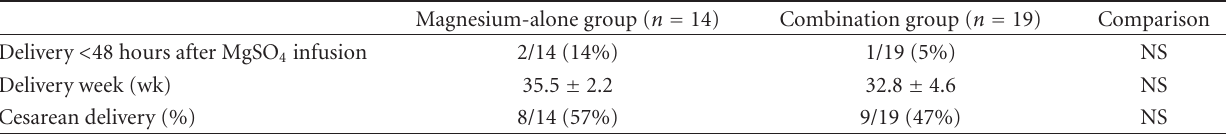
Table 2: Obstetric characteristics at the start of the allocated treatment.